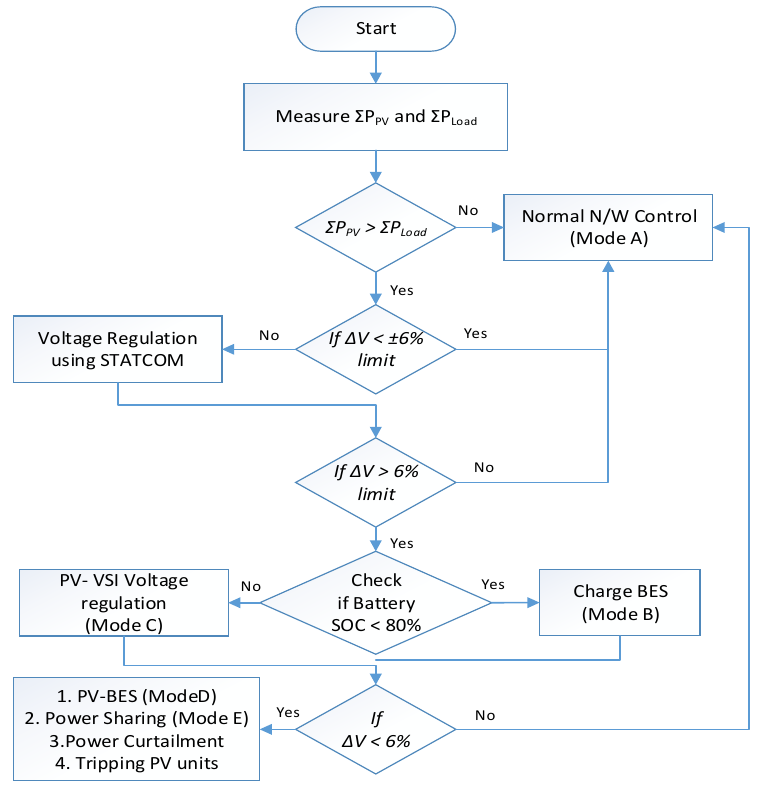
Figure 4. Flowchart of Hierarchal control algorithm.